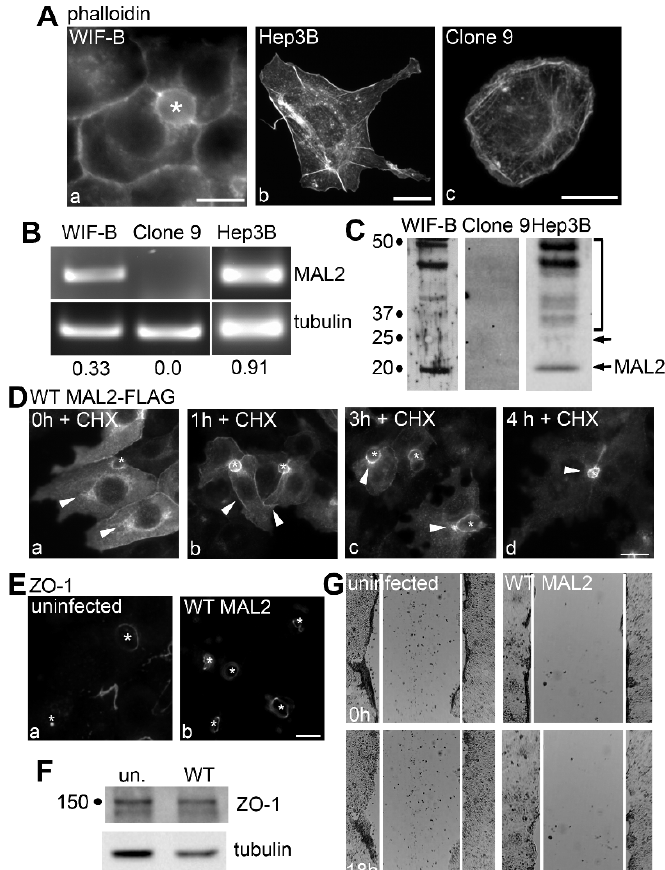
Figure 2. MAL2 is expressed in normal and malignant liver-derived cell lines, but simply overexpressing MAL2 in polarized WIF-B cells is not oncogenic. ( A ) WIF-B (a), Hep3B (b) and Clone 9 cells (c) were labeled for actin with phalloidin. ( B ) Agarose gels are shown of MAL2 (upper panels) and α-tubulin (lower panels) cDNA amplified by RT-PCR from 1 µg total RNA isolated from WIF-B, Clone 9 or Hep3B cells as indicated. Human-specific MAL2 and α-tubulin primers were used for Hep3B cell amplification while rat-specific primers were used for WIF-B and Clone 9 cells. Numbers below the lanes represent the ratio of MAL2 mRNA expression levels normalized to α-tubulin expression levels. ( C ) Lysates from WIF-B and Clone 9 cells were immunoblotted with antibodies specific for rat MAL2 and lysates from Hep3B cells were immunoblotted for human MAL2. Molecular weight standards are indicated on the left in kDa. The bottom arrow marks the predicted 19 kDa MAL2 immunoreactive species. The bracket highlights a diffuse set of bands that has been described by us and others and the upper arrow indicates a 25 kDa species also detected by others. ( D ) WIF-B cells expressing FLAG-tagged wild type (WT) MAL2 were treated with 50 µg/mL of cycloheximide (CHX) for up to 4 h as indicated and immunolabeled for MAL2 with anti-FLAG antibodies. Arrowheads indicate MAL2 localization at the Golgi (a), basolateral membrane (b) SAC (c) or apical surface (d). Asterisks mark bile canaliculi. ( E ) Uninfected WIF-B cells and cells overexpressing wild type MAL2 were immunolabeled for ZO-1. Asterisks indicate bile canaliculi. ( F ) Lysates from uninfected or MAL2-overexpressing cells were immunolabeled for ZO-1 and tubulin as indicated. Molecular weight standards are indicated on the left in kDa. ( G ) Uninfected WIF-B cells or cells overexpressing MAL2 were subjected to a scratch assay. Wound healing was analyzed 0 h (upper panels) and 18 h (lower panels) after the scratch. White lines indicate the edges of the gap. Bar = 10 µm.